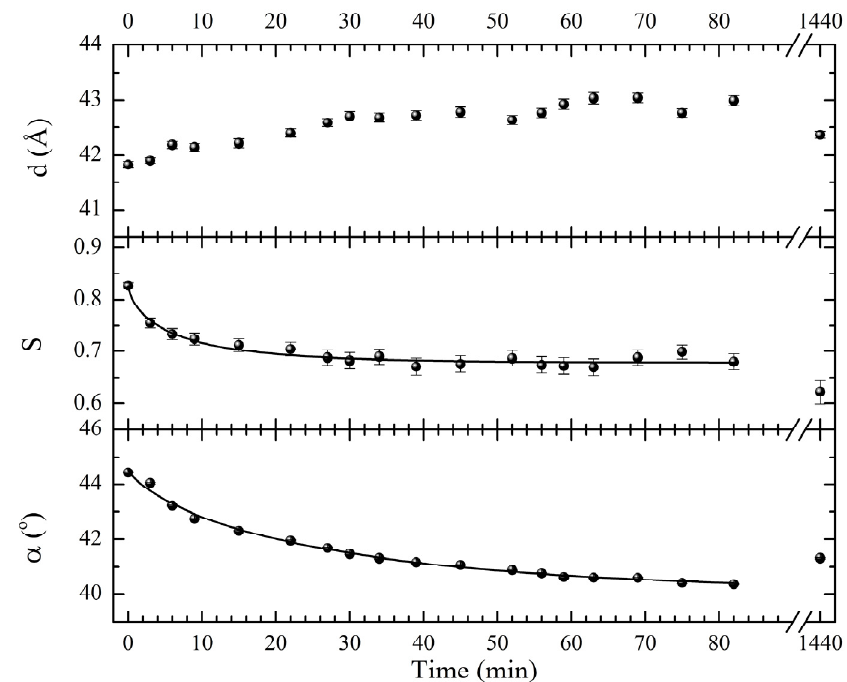
Figure 15. LCE1: Time dependence of d , S and α after removal of applied uniaxial strain for LCE1. The solid curves are fits to Equation 2. Equilibrium state was achieved after ca . 90 min with S = 0.68 ± 0.01 and α = 40.0 ° ± 0.2 ° . The fitting exponent is almost the same; (0.70 ± 0.12) for S and (0.77 ± 0.07) for α . The relaxation time (26.3 ± 3.4 min) for angle α is approximately four times larger than (6.4 ± 1.0 min) of S